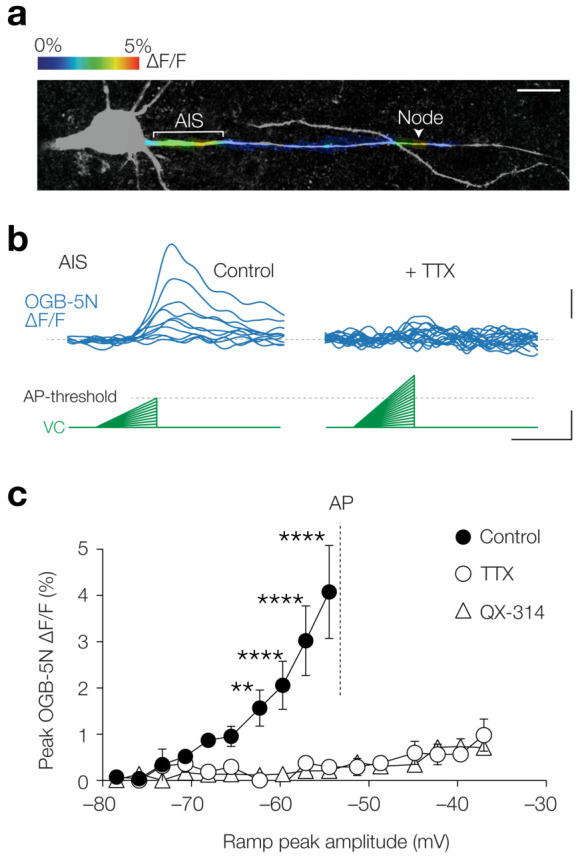
Subthreshold [Ca2+]i changes are TTX sensitive.(a) Example image of color-coded maximal ∆F/F (1 mM OGB-5N) along the proximal axon in response to a voltage ramp from –78.5 mV to maximally –54.5 mV. Acquisition rate was 125 Hz. The color-coded image is overlaid with a maximal z-projection of a confocal scan of biocytin/streptavidin staining (grey) of the same axon. Note the compartmentalized Ca2+ influx at the AIS and node (indicated by a white arrow). Scale bar, 20 µm. (b) Example traces of OGB-5N ΔF/F reveal increasing Ca2+ responses to voltage ramps with increasing incline in control (left) but not in TTX (1 µM, right). Traces filtered with one-pass binomial (three point). Scale bars, 1% ∆F/F, 10 mV and 50 ms. (c) Population data for maximal OGB-5N ΔF/F versus voltage ramp peaks in control (closed circles, n = 4), in TTX (open circles, n = 4) or QX-314 (open triangles, 6 mM, n = 4). Two-way ANOVA with Tukey’s multiple comparisons test, **p<0.01, ****p<0.0001. AP threshold is indicated with a gray line. Data are shown as mean ± s.e.m. Data available in Figure 4—source data 1.